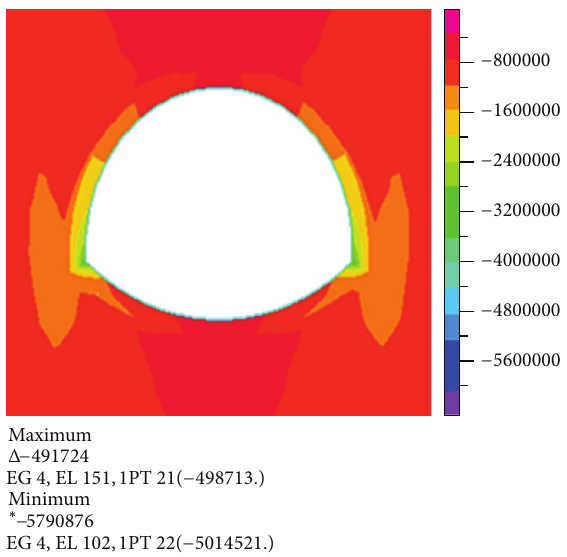
Figure 4: Nephogram of the first principal stress. Figure 5: Nephogram of the third principal stress.